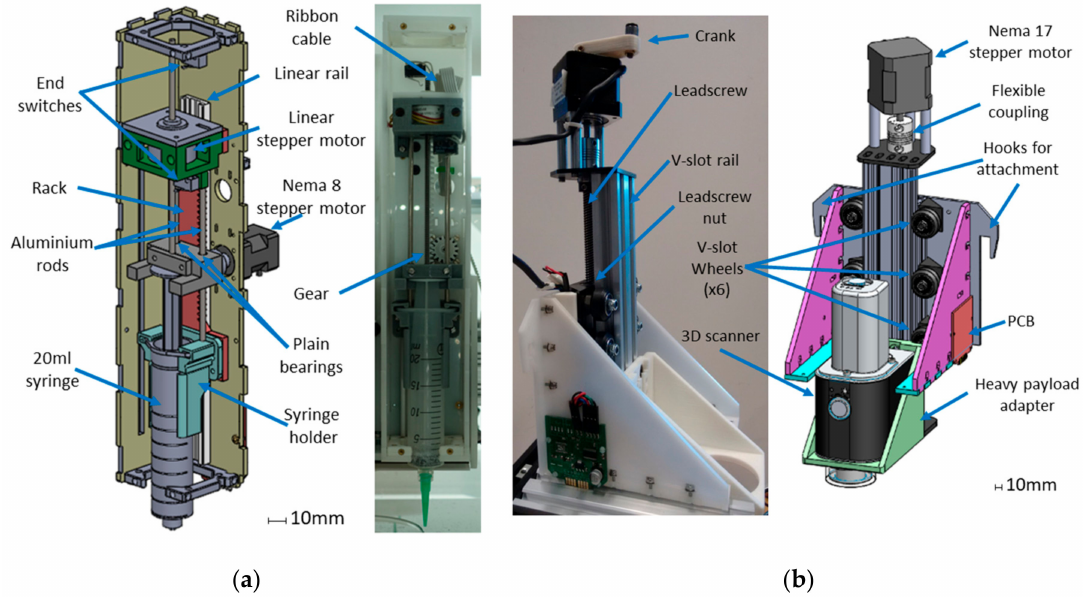
Figure 5. Main mechanical components of two modules: ( a ) Syringe module. ( b ) Heavy payload